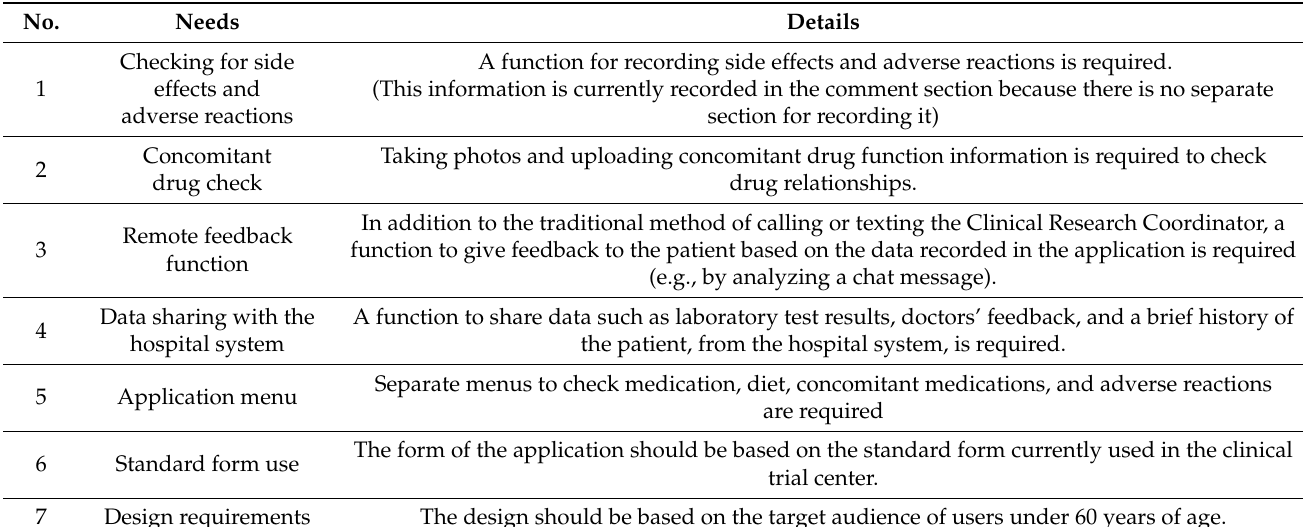
Table 1. Collected needs for the real-time clinical trial monitoring